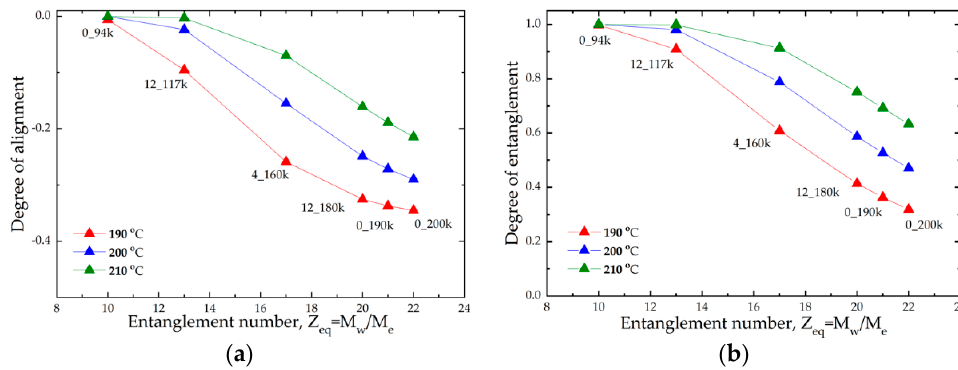
Figure 8. ( a ) Degree of alignment and ( b ) degree of entanglement calculated for different nozzle temperatures as a function of Z eq = M w / M e